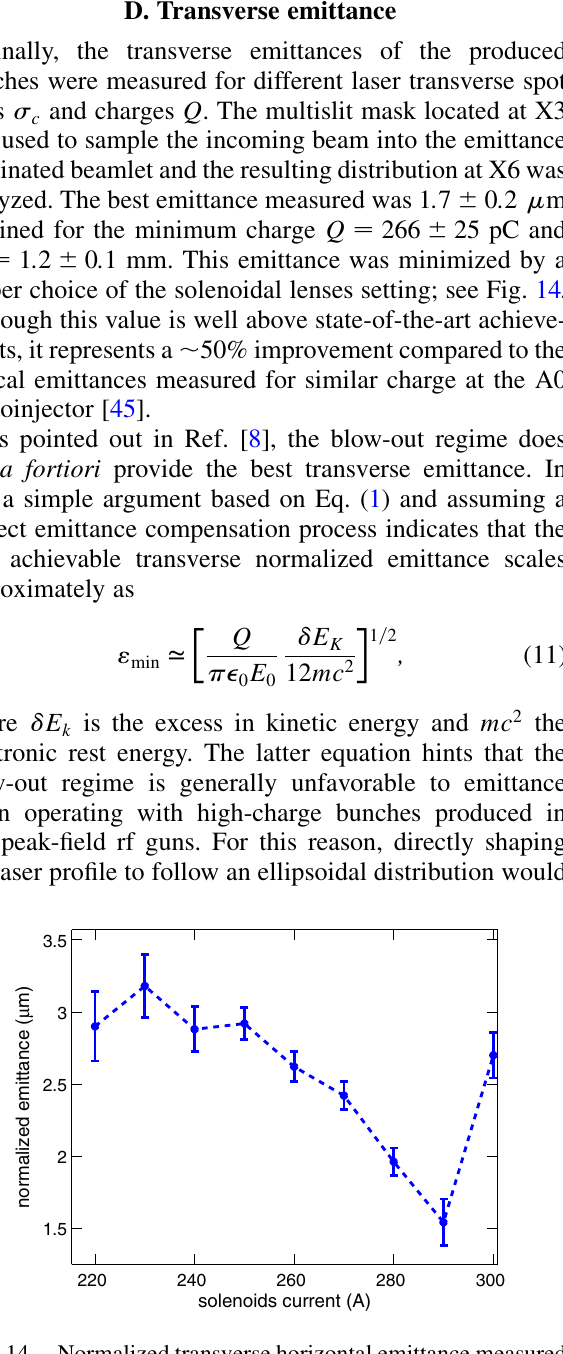
FIG. 14. Normalized transverse horizontal emittance measured as a function of the current setting of the solenoidal lenses (shown as L1, L2, and L3 in Fig. 2) for Q ¼ 266 (cid:5) 25 pC